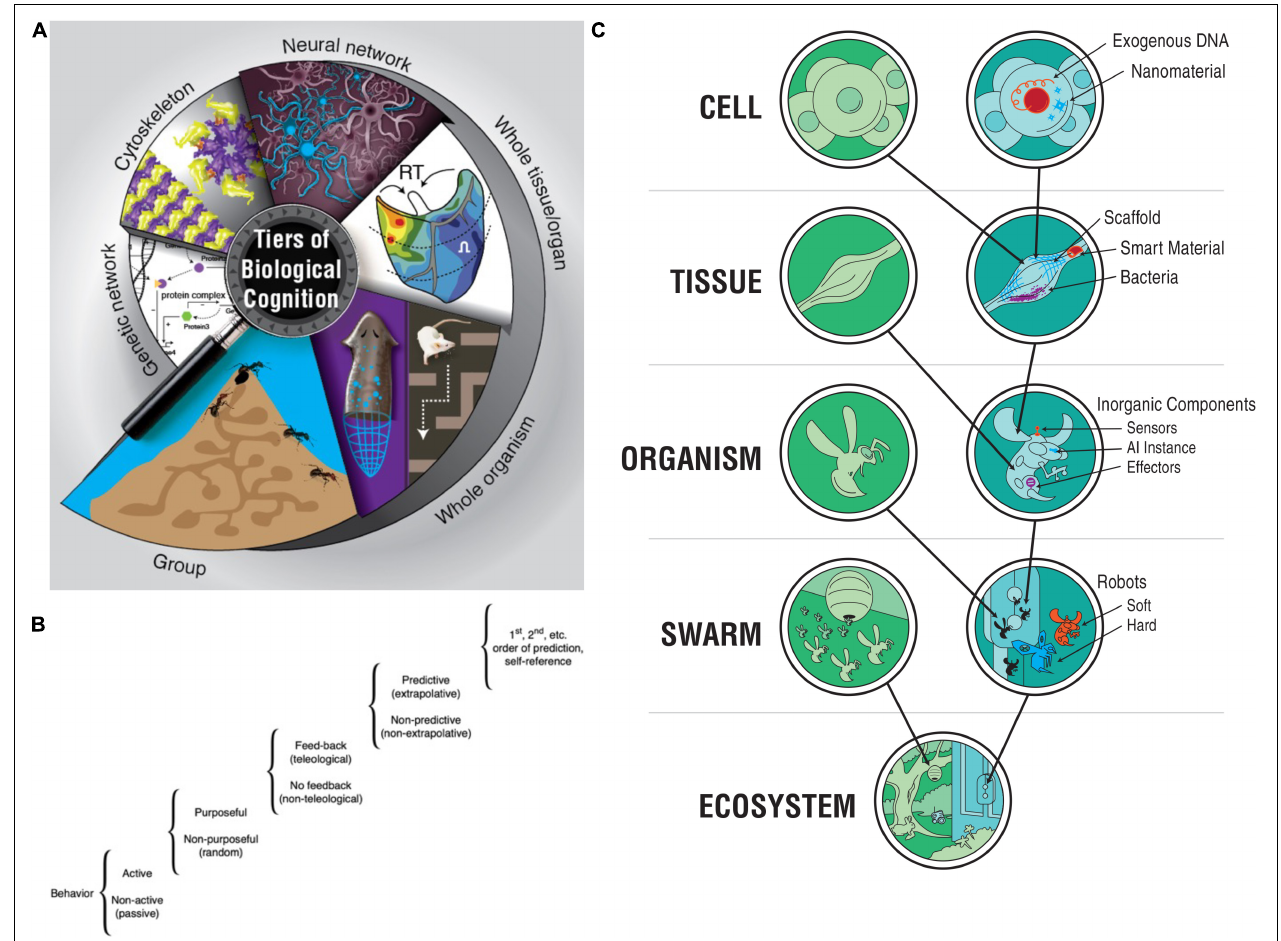
FIGURE 1 | Diverse, multiscale intelligence. (A) Biology is organized in a multi-scale, nested architecture of molecular pathways. (B) These are not merely structural, but also computational: each level of this holarchy contains subsystems which exhibit some degree of problem-solving (i.e., intelligent) activity, on a continuum such as the one proposed by Rosenblueth et al. (1943). (C) At each layer of a given biosystem, novel components can be introduced of either biological or engineered origin, resulting in chimeric forms that have novel bodies and novel cognitive systems distinct from the typical model species on the Earth’s phylogenetic lineage. Images in panels (A,C) by Jeremy Guay of Peregrine Creative. Image in panel (B) was created after Rosenblueth et al.